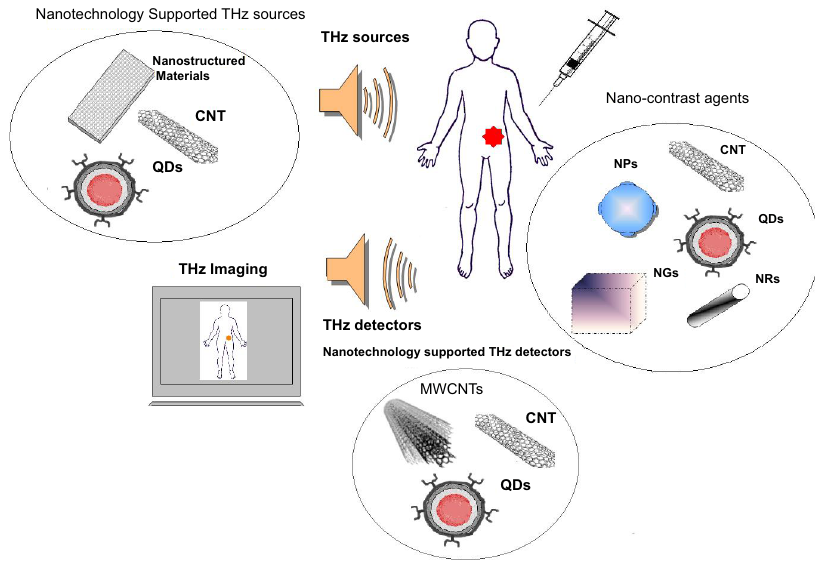
Figure 2. Nanotechnology-supported THz imaging. Nanotechnology methods are used in all the components of THz imaging: contrast agents, sources and detectors (CNT: Carbon Nanotubes, QDs: Quantum Dots, NPs: Nanoparticles, NRs: nanorods, NGs: nanocages, WCNTs: multi-walled CNTs).